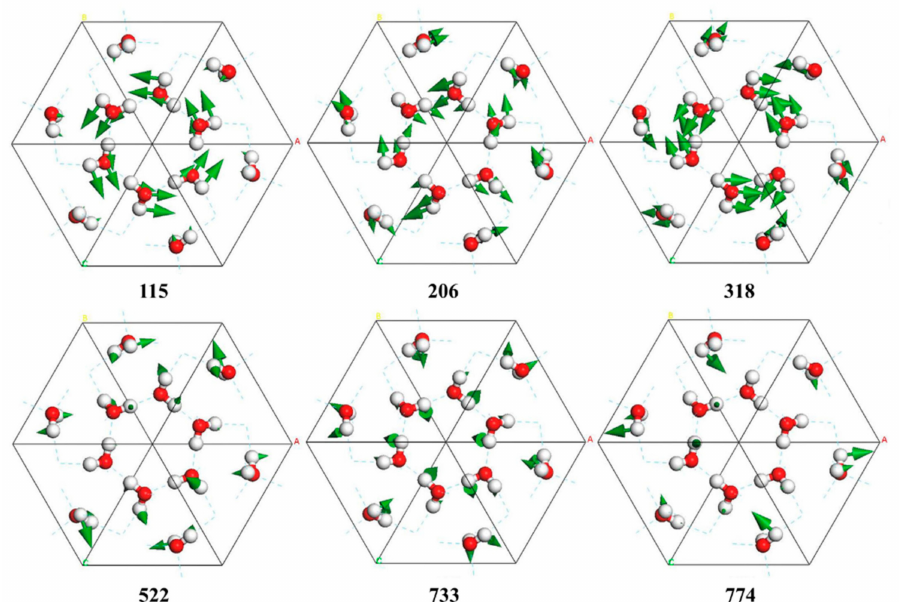
Figure 2. Top view of six normal modes in the translation band (115, 206, and 318 cm − 1 ) and libration band (522, 733, and 774 cm − 1 ). Green arrows represent vibration direction in sizes proportional to the vibration amplitude.